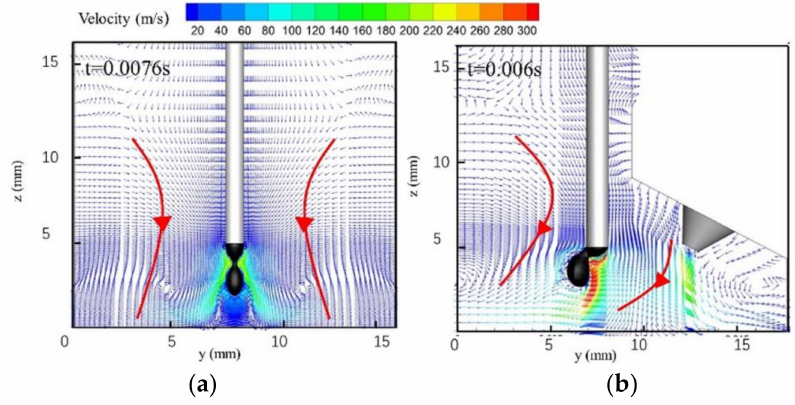
Figure 10. The arc velocity distribution: ( a ) MIG; ( b ) TIG-MIG.